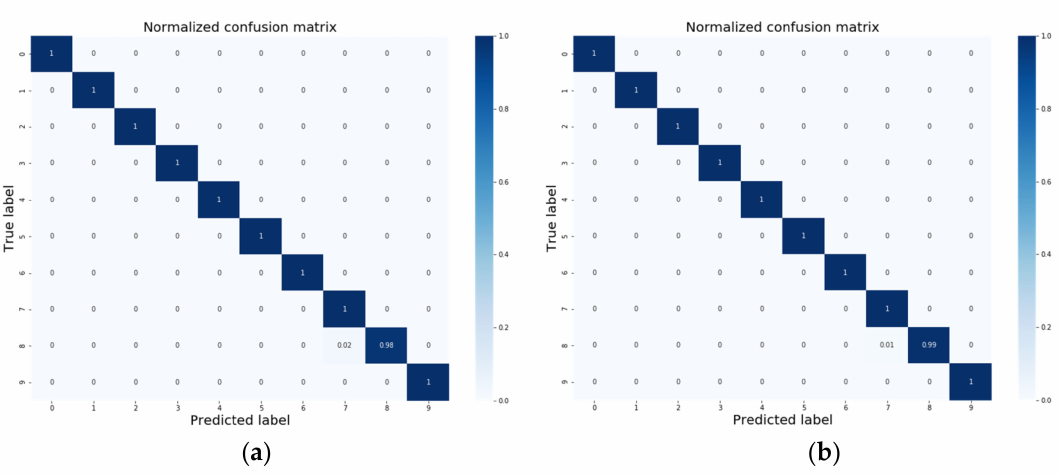
Figure 6. Confusion matrices of Tasks D → A: ( a ) Accuracy: 99.80%; ( b ) Accuracy: 99.90%. Category 0: No, Category 1: 0.007 / IF, Category 2: 0.014 / IF, Category 3: 0.021 / IF, Category 4: 0.007 / OF, Category 5: 0.014 / OF, Category 6: 0.021 / OF, Category 7: 0.007 / RF, Category 8: 0.014 / RF, Category 9: 0.021 /